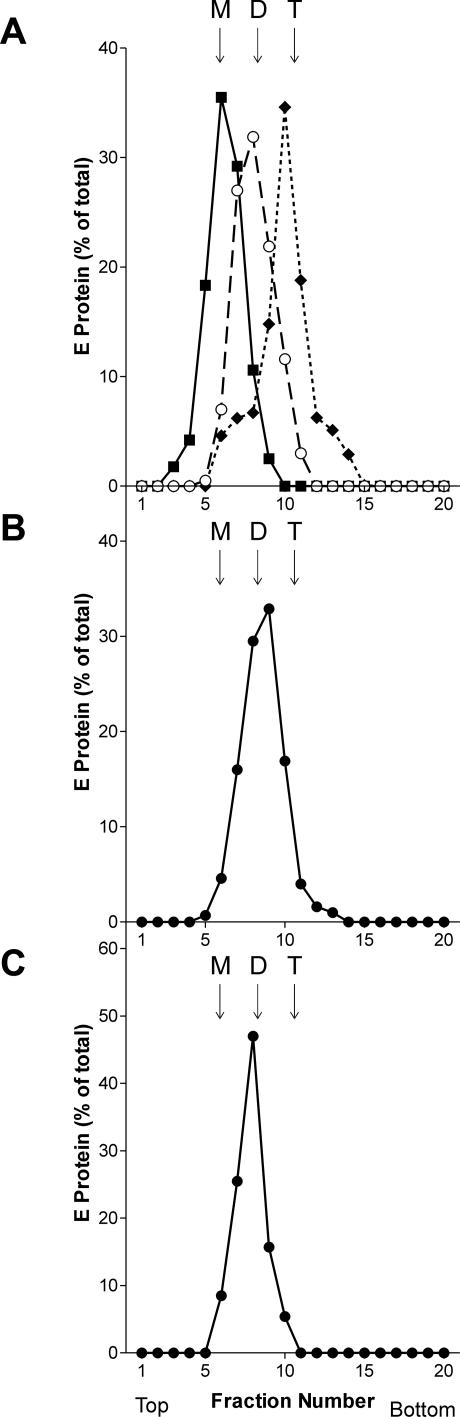
Sedimentation Analysis Demonstrating the Alkaline pH–Induced Dissociation of E and Its Reversibility(A) Virions were incubated for 10 min at pH 10.0 (boxes), pH 5.4 (diamonds), or pH 8.0 (circles), solubilized with Triton X-100, and analyzed at the respective pH by sedimentation in 7% to 20% sucrose gradients (w/w) containing 0.1% Triton X-100.(B) Material from the alkaline pH–induced E monomer peak in Figure 2A was back-neutralized to pH 8.0 and then centrifuged at pH 8.0 into 7% to 20% sucrose gradients (w/w) in buffer containing 0.1% Triton X-100.(C) Alkaline pH–treated virions were readjusted to pH 8.0, then solubilized with Triton X-100, and centrifuged at pH 8.0 in 7% to 20% sucrose gradients (w/w) in buffer containing 0.1% Triton X-100.The sedimentation direction is from left to right, and the positions of E monomer (M), dimer (D), and trimer (T) are indicated.